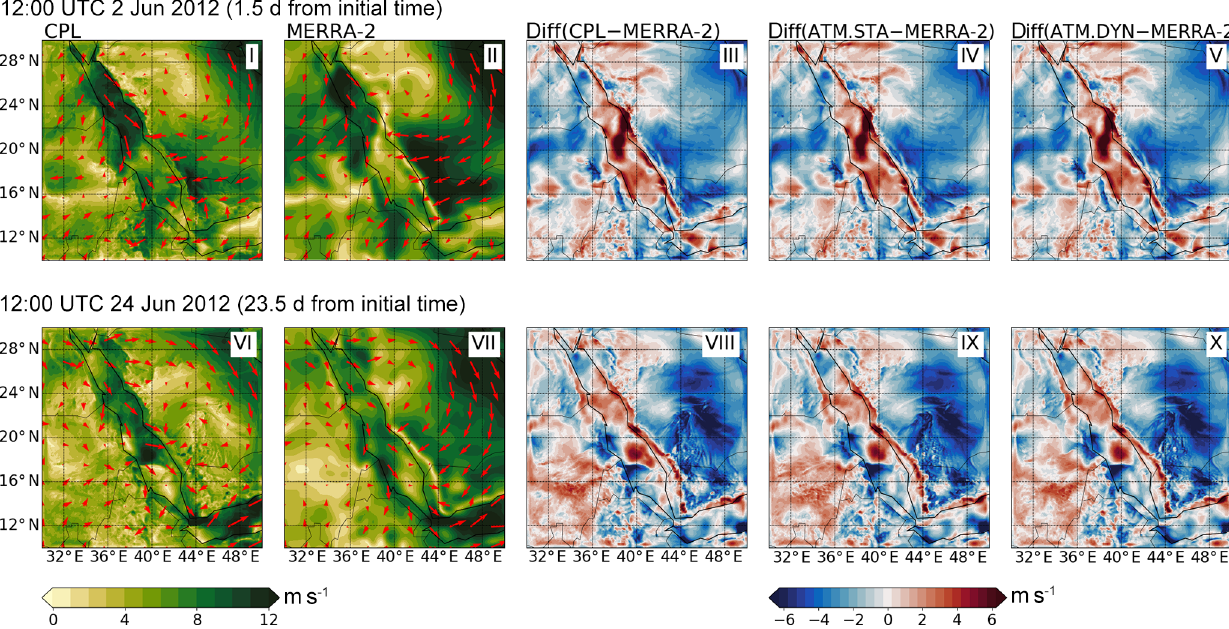
Figure 12. The magnitude and direction of the 10m wind obtained in the CPL, the MERRA-2 data, and their difference (CPL − MERRA- 2). The differences between ATM.STA and ATM.DYN with MERRA-2 (i.e., ATM.STA − MERRA-2, ATM.DYN − MERRA-2) are also presented. Two snapshots are selected: (1) 12:00UTC 2 June 2012 and (2) 12:00UTC 24 June 2012.